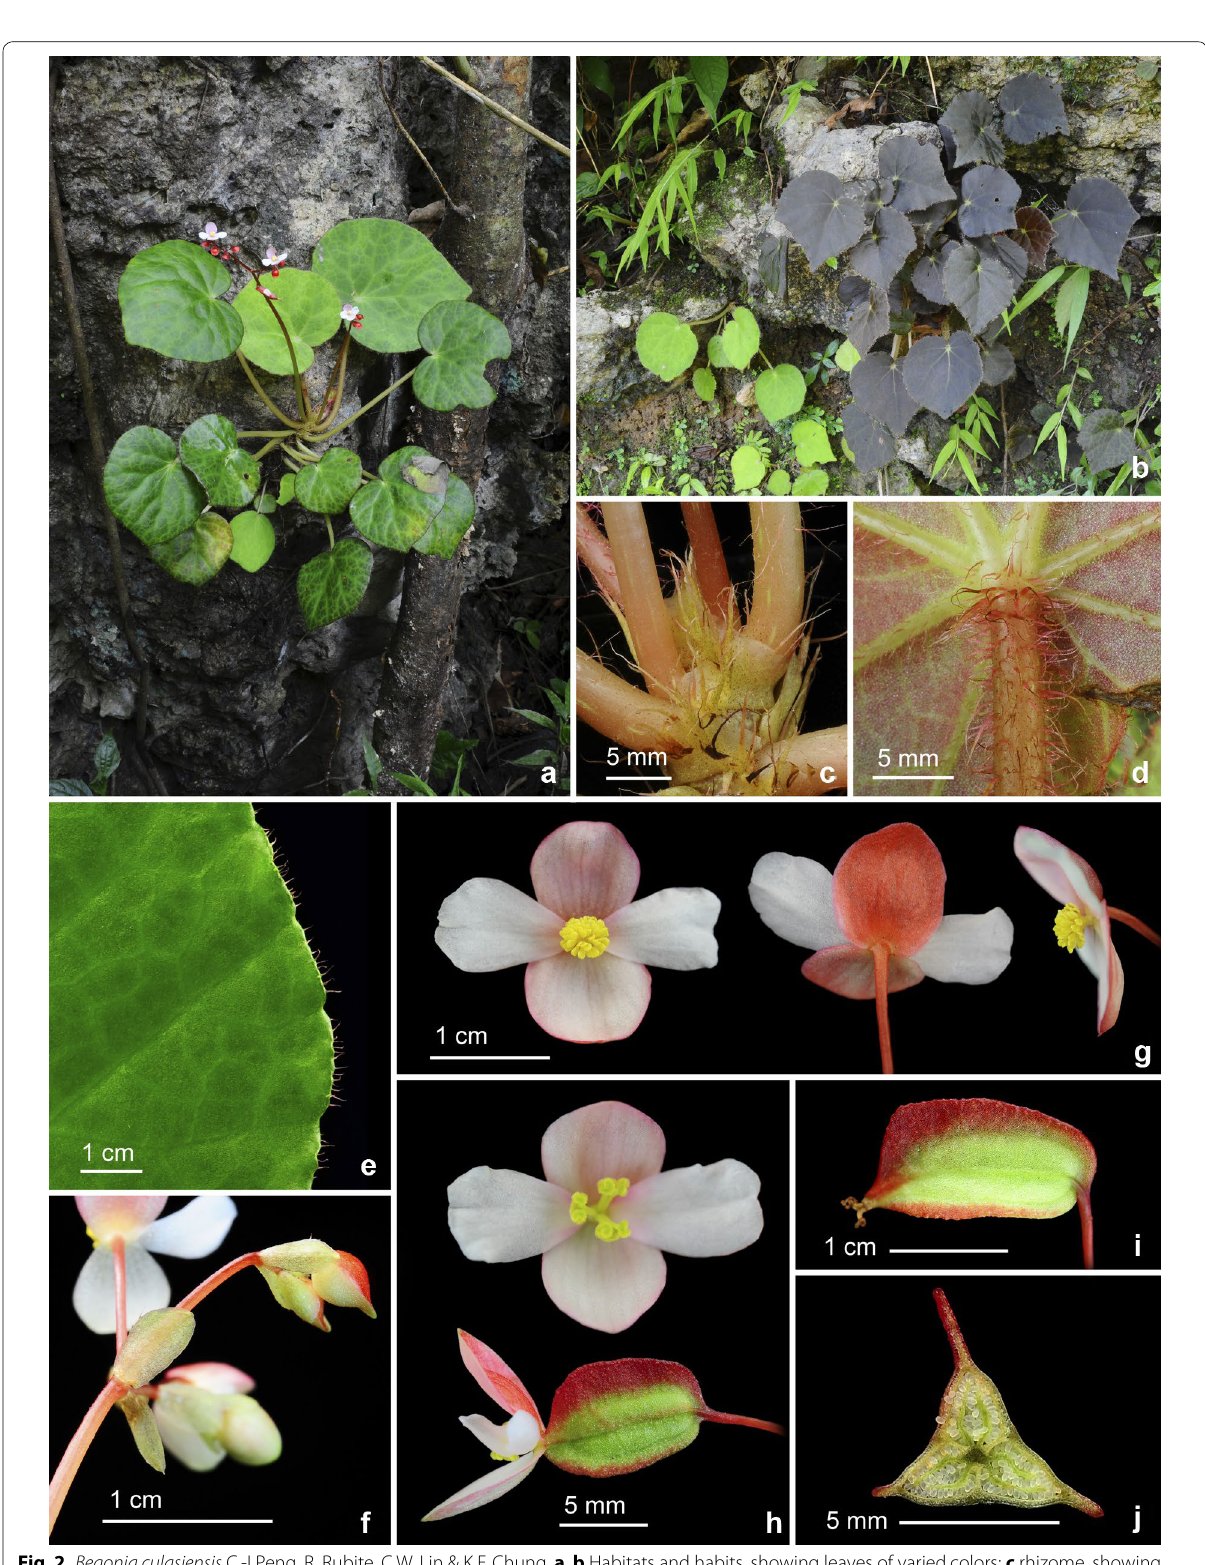
Fig. 2 Begonia culasiensis C.‑I Peng, R. Rubite, C.W. Lin & K.F. Chung. a , b Habitats and habits, showing leaves of varied colors; c rhizome, showing stipules and petiole base; d distal part of petiole; e portion of leaf, showing ciliate margin; f Inflorescence, showing bracts; g staminate flowers; h pistillate flowers; i capsules; j cross section of an immature